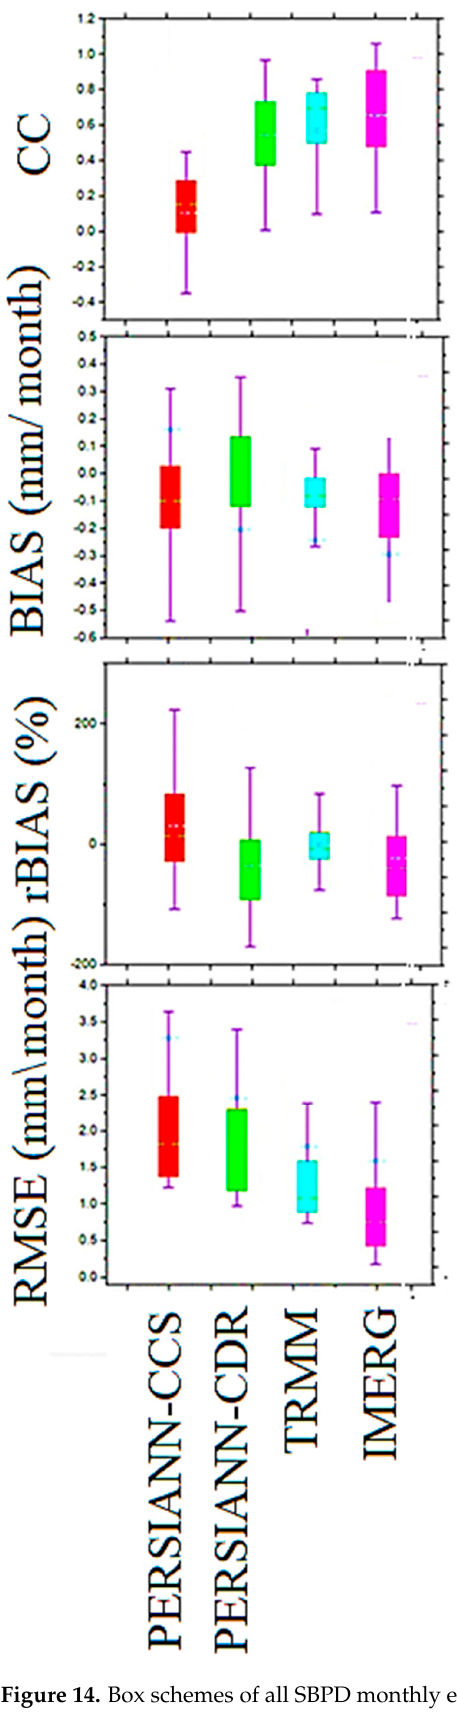
Figure 14. Box schemes of all SBPD monthly estimations .